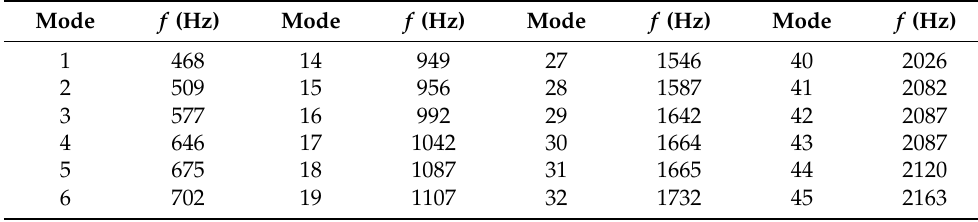
Figure 13. Illustration of the lowest and highest normal mode shapes included in the modal representation. ( a ) Mode 1. ( b ) Mode 50. Table 4. Structural